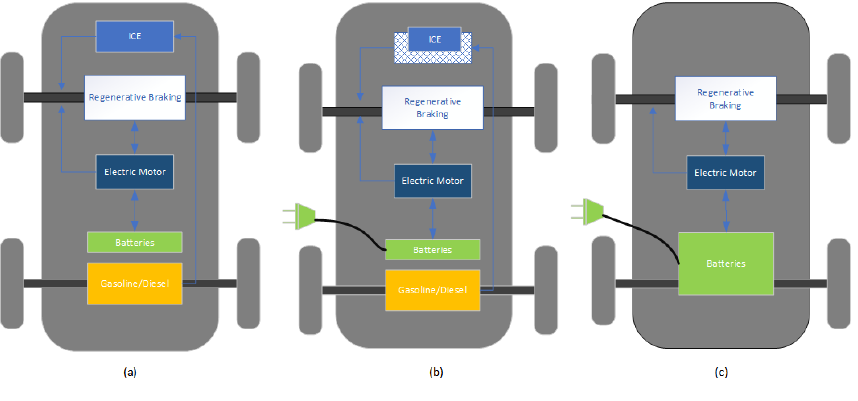
Figure 2. Basic structure of different EV types. ( a ) HEV. ( b ) PHEV. ( c )